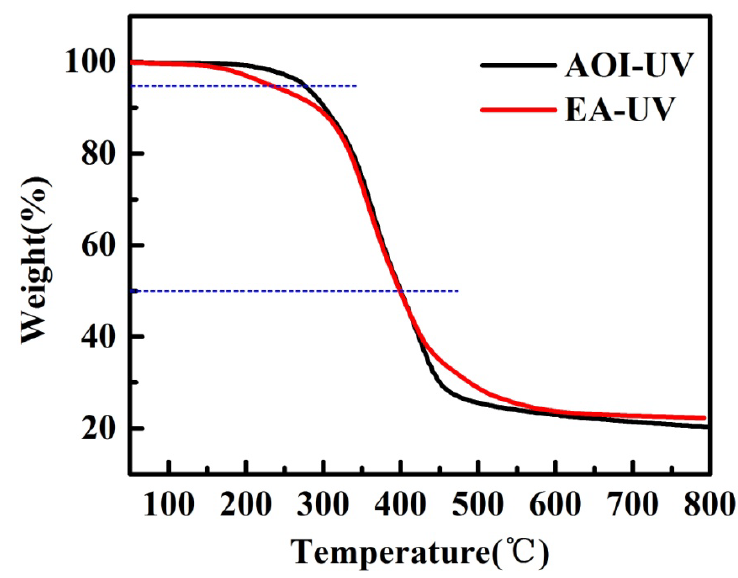
Figure 8. Thermal weight loss curves of high refractive index films. Table 1. Thermal weight loss test results of two high refractive index UV cured films.